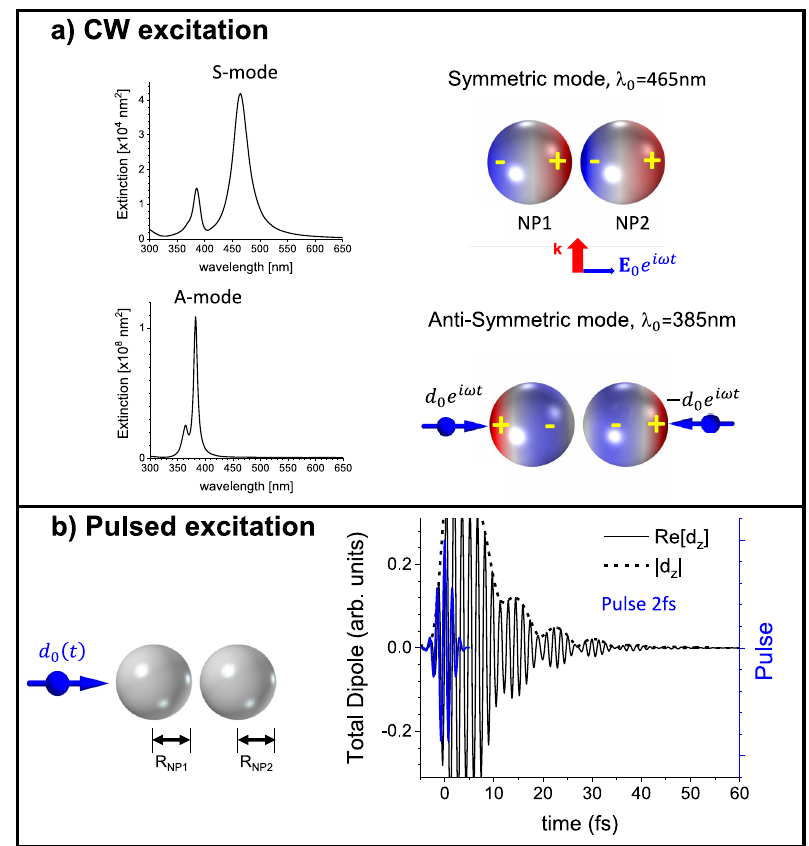
Figure 2: (a) Extinction spectra and